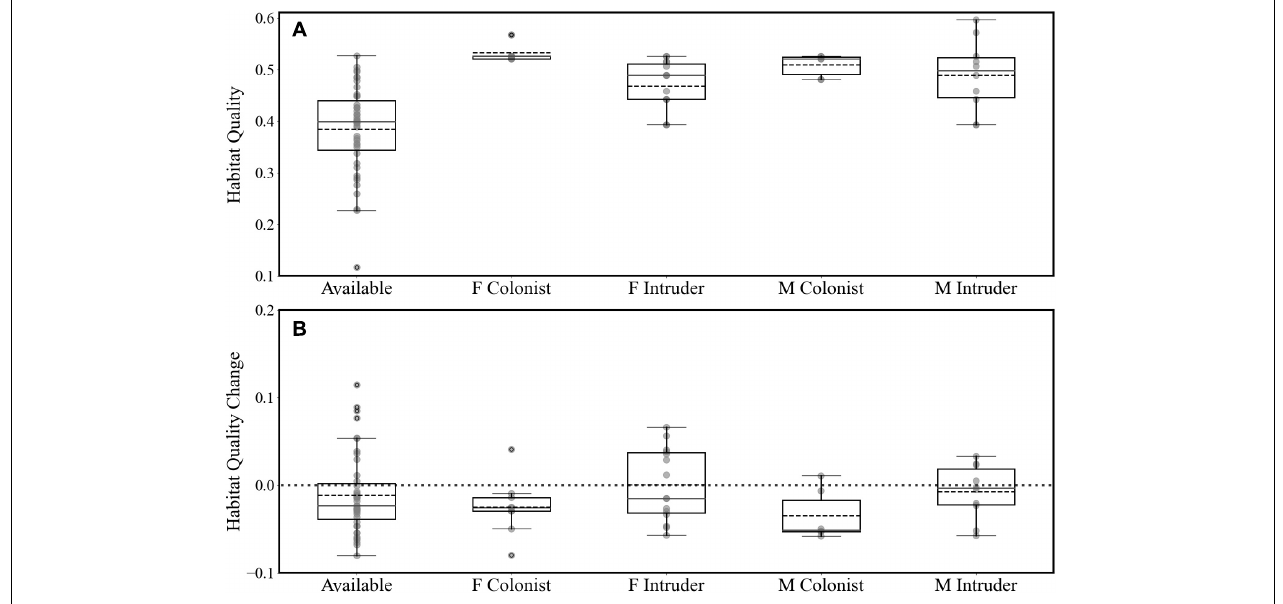
FIGURE 6 | (A) Distribution of the estimated mean habitat quality for release areas (circles with 1-km radius around release sites) and (B) the distribution of the difference in mean habitat quality between release sites and final home ranges of released fishers (positive values indicate that habitat quality in home ranges is higher than at release sites). We calculated habitat quality for fishers’ home ranges for the area within the 50% isopleths and for available habitat.at randomly distributed circles with 1-km radius, Fishers released where no conspecifics hade established home ranges (F Colonist), Fishers released within the established home ranges of other fishers we call Intruders. Fishers released where no other fishers had established home ranges we called Colonists. Dashed black center lines are mean values and solid gray lines are medians.